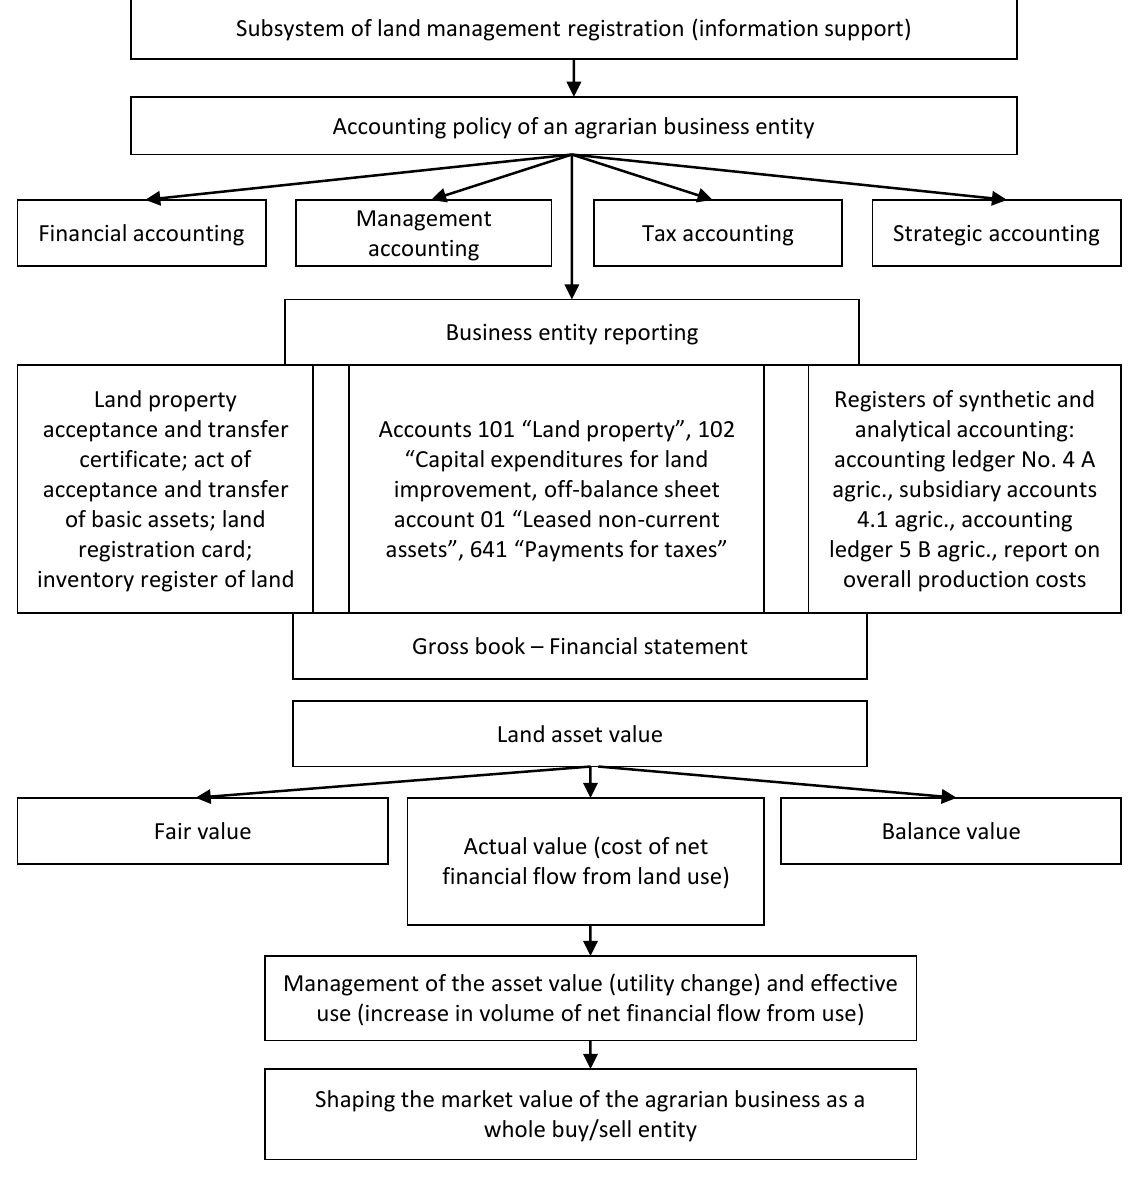
Figure 1. Subsystem of information provision of accounting and analytical support for land